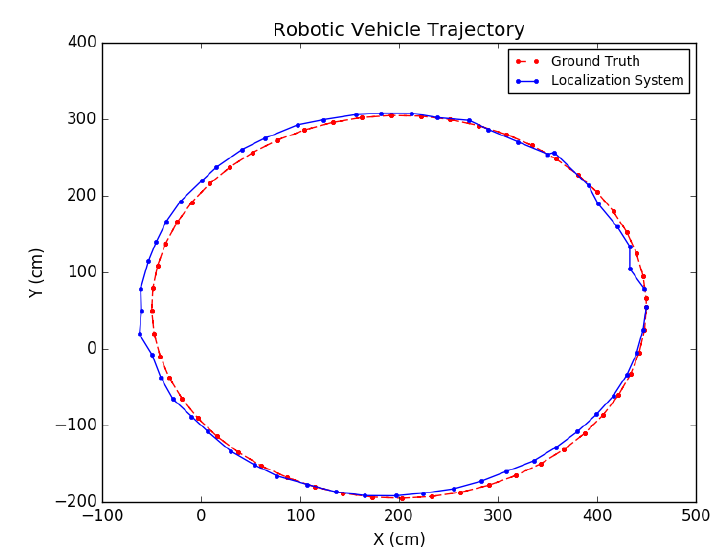
Figure 23. Simulation test trajectory